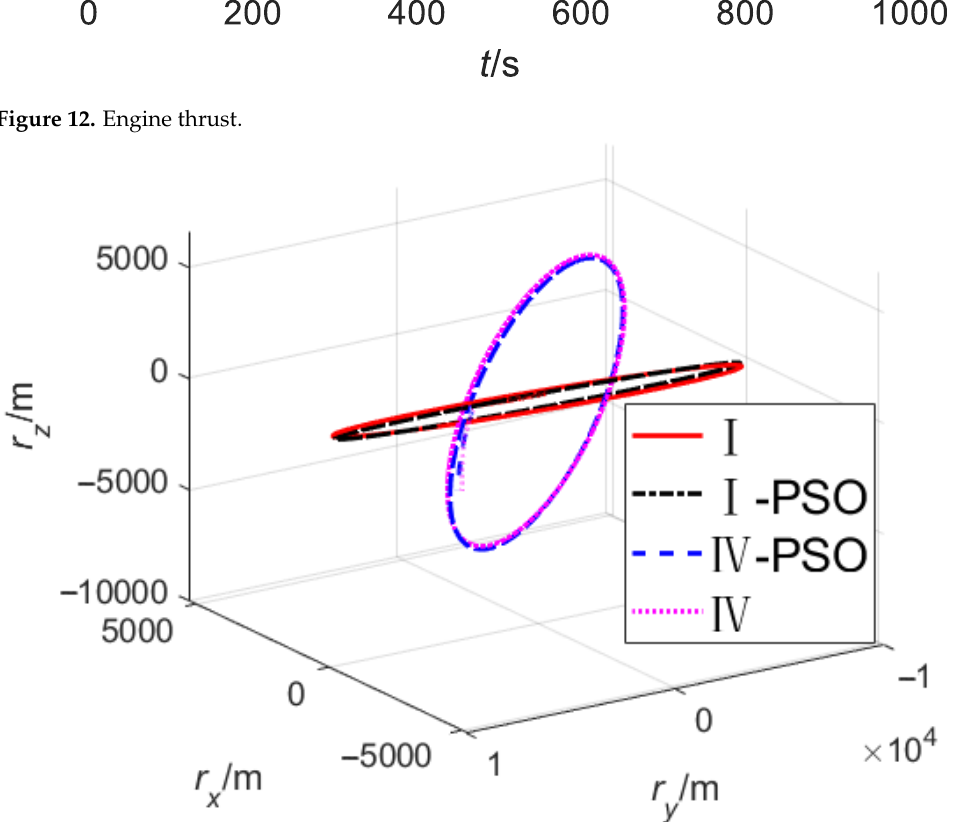
Figure 13. Flight trajectory and terminal